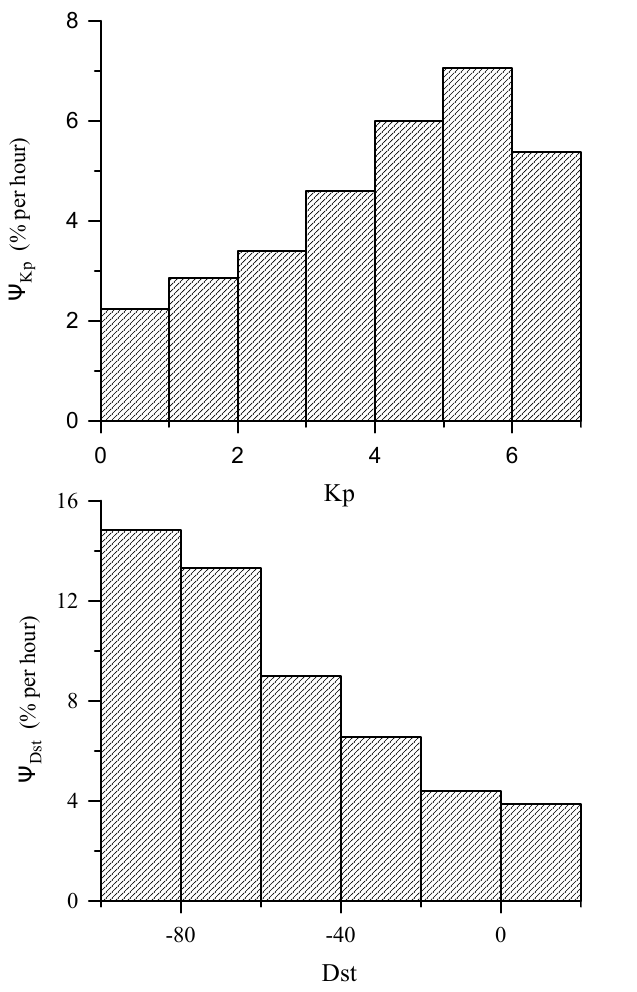
Fig. 3. The dependence of the NETE occurrence probability 9 K and 9 D on a 3-h geomagnetic index K p (top panel) and 1-h index st D st (bottom panel). Fig. 4 Fig. 4. The dependence of the NETE occurrence probability 9 K